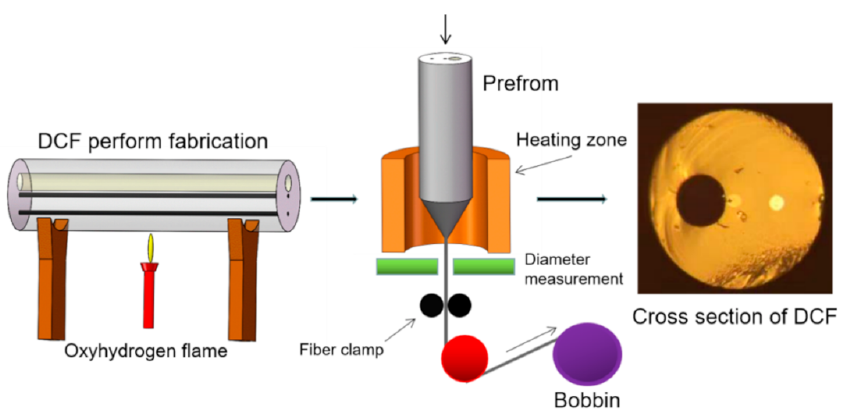
Figure 1. Schematic of the fabrication process of the dual-core fiber